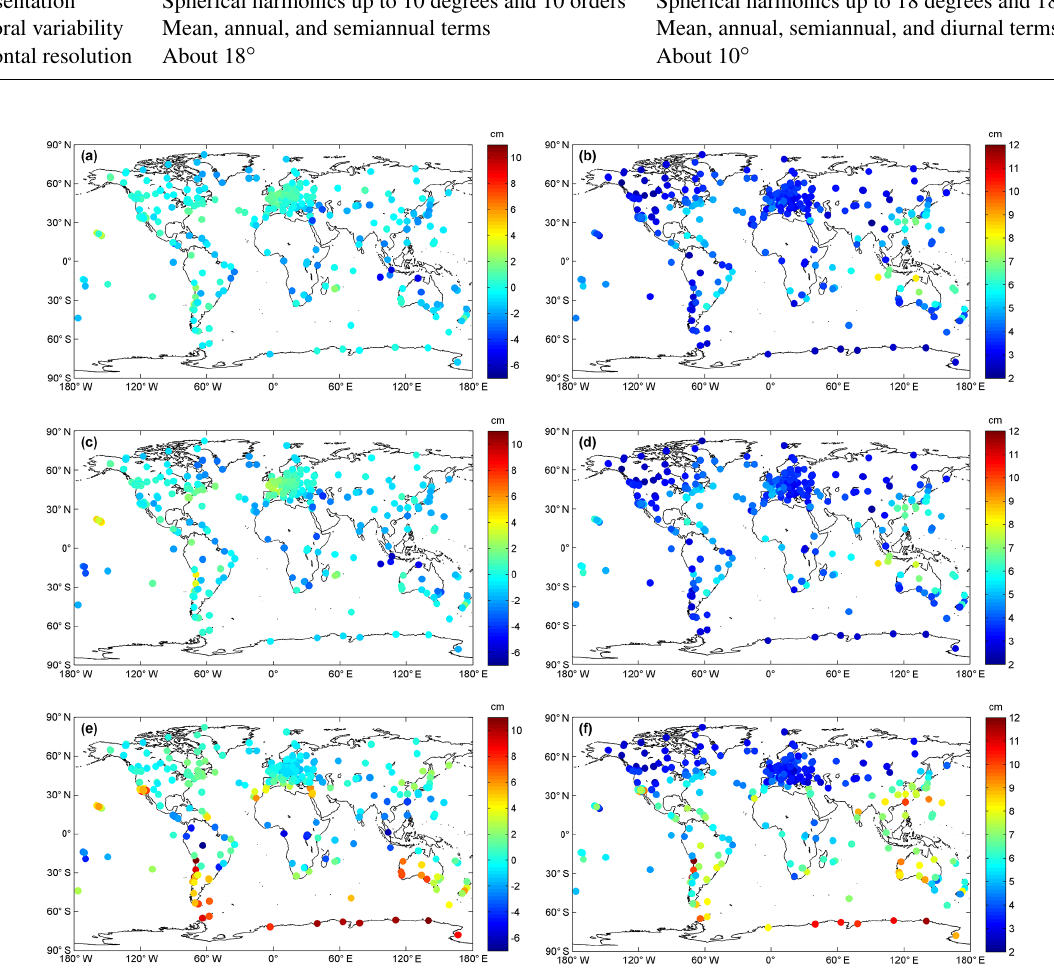
Figure 8. Global distributions of bias and rms for different models. (GZTD2 bias (a) , GZTD2 rms (b) , GZTD bias (c) , GZTD rms (d) , UNB3m bias (e) , UNB3m rms (f)